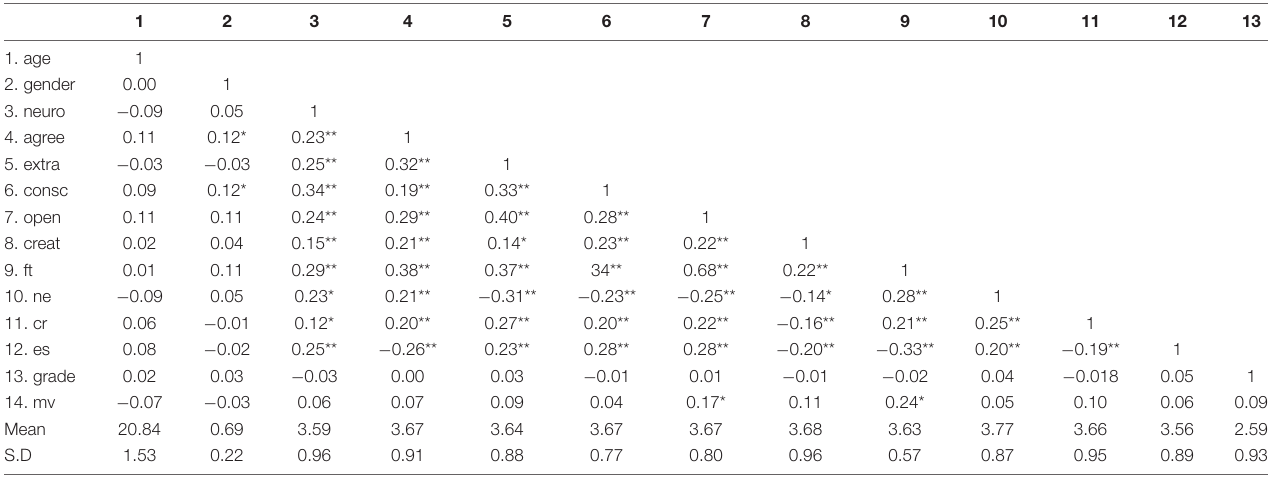
TABLE 1 | Correlation matrix.